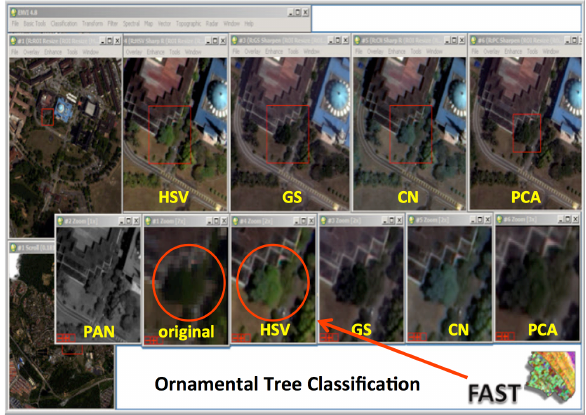
Figure 4. FAST application example